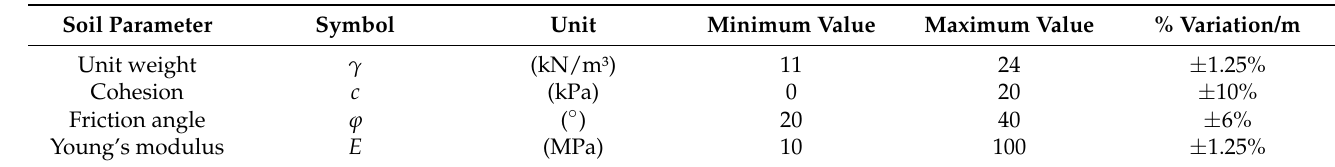
Table 2. Range of the intervals of soil properties and their coefficient of variation for every 2 m excavation